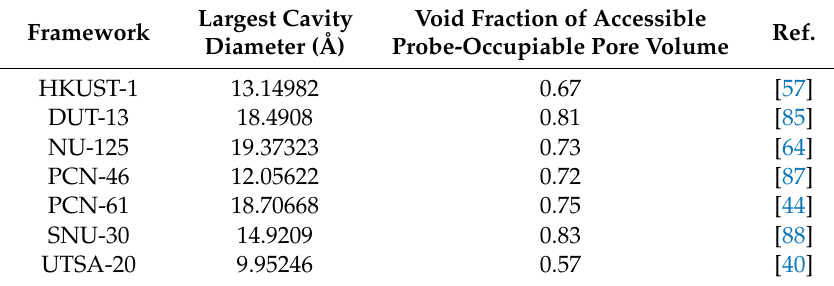
Table 3. Physical characteristics of MOF frameworks [86].